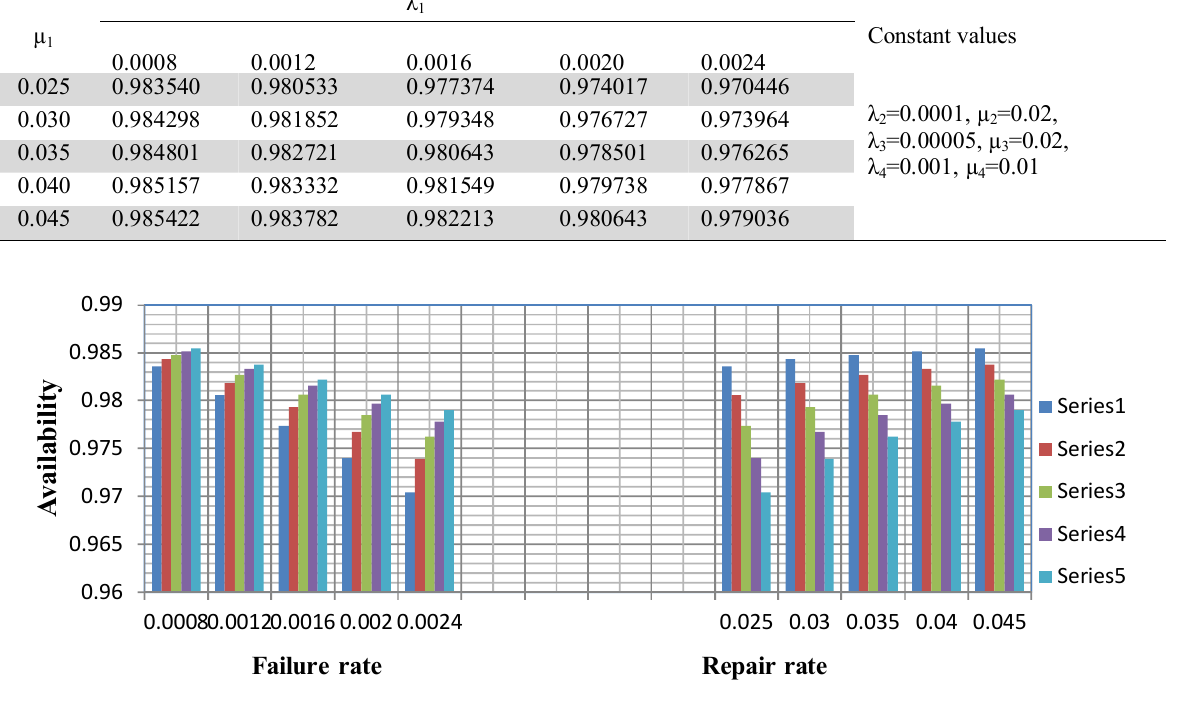
Fig. 2. Effect of Failure and Repair Rates of Air heater (A